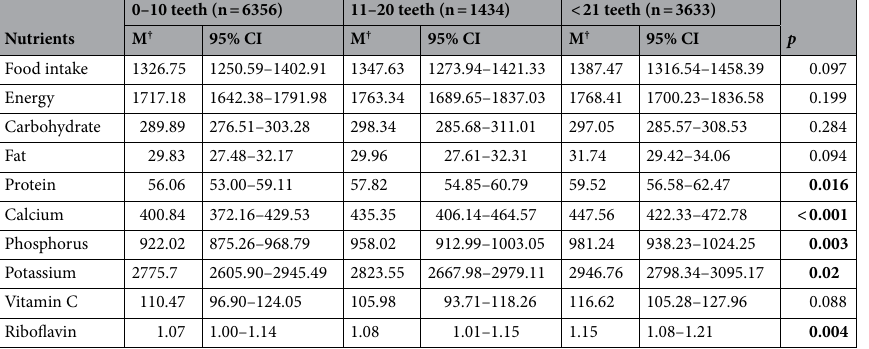
Table 2. Adjusted geometric means of daily nutrient intake by number of existing teeth*. The data was analyzed by complex samples general linear model. Bold values denotes statistical significance at p < 0.05. *Adjusted for age, sex, household income, smoking status, alcohol consumption, use of floss, use of interproximal brush, hypertension, obesity, and diabetes. † Geometric mean.